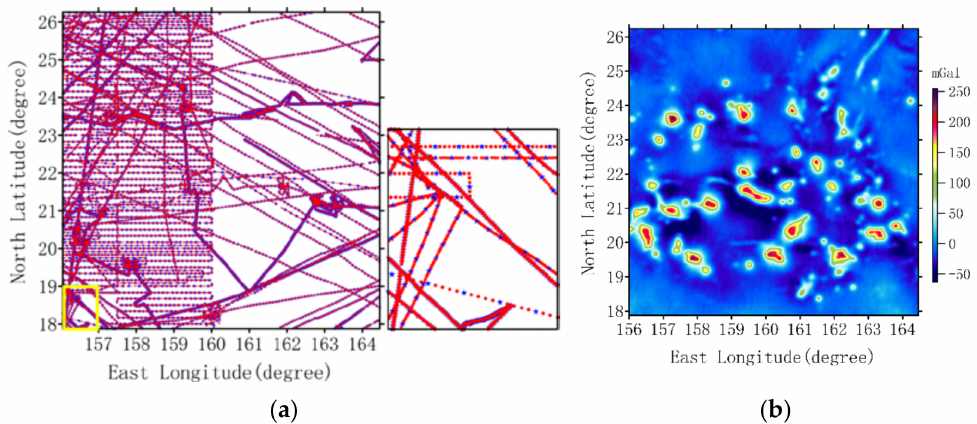
Figure 1. Experimental data of the study area. ( a ) Distribution of shipborne depth measurements points. The details of the yellow box area are shown in the small picture on the right. The red solid dots are check data. The blue star dots are control data. ( b ) Gravity anomaly data by satellite